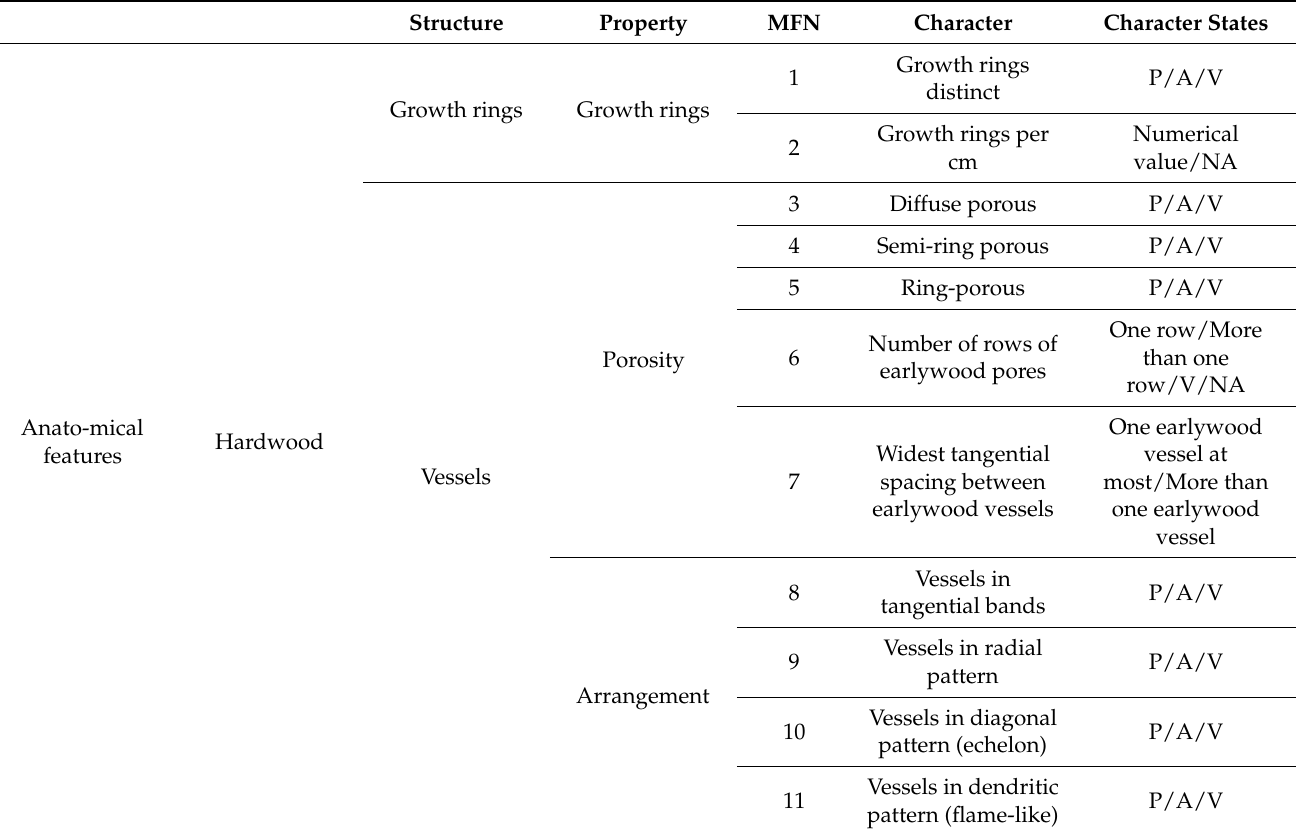
Table 1. List of macroscopic features for hardwood and softwood identification according to [4].